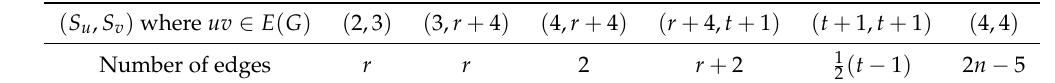
Table 11. The edge partition of the graph G for k = 2.